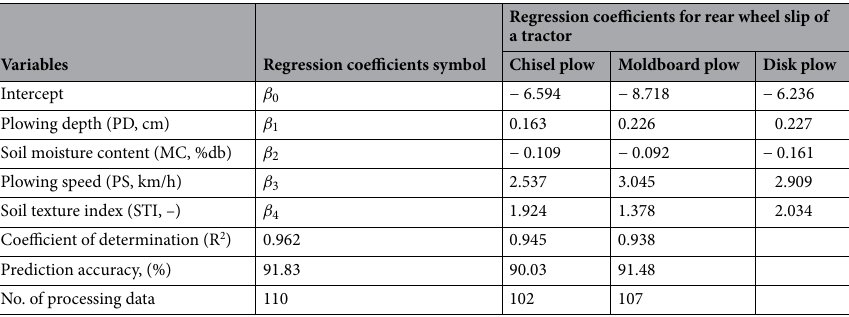
Table 3. Regression coefficients for rear wheel slip of a tractor during tillage process using different tillage implements.